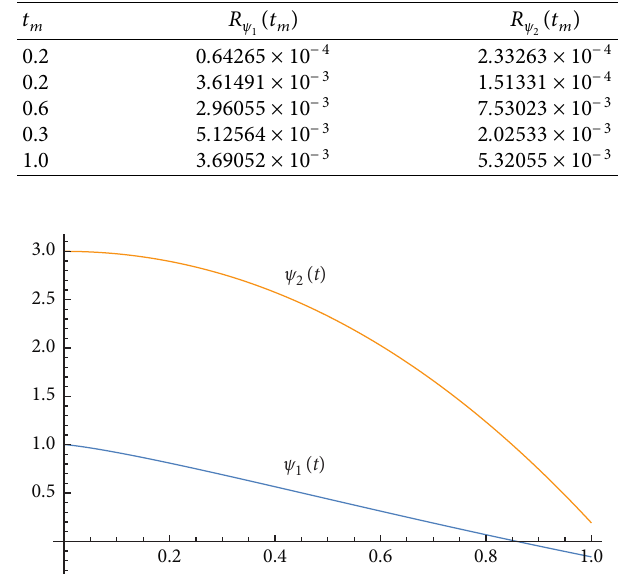
Figure 1: Graphs of the approximated solutions ψ for Case i. Table 1: Residuals R